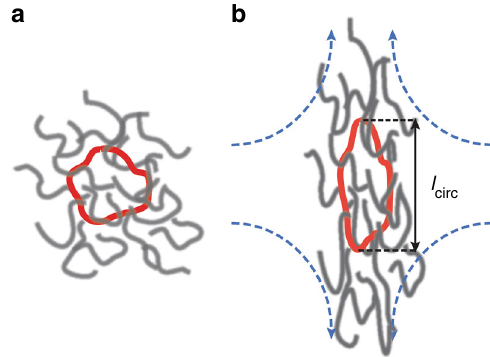
Fig. 1 Schematic of the experimental ring-linear system. Fluorescently labeled tracer ring DNA molecules (45 kbp, shown in red) are uniformly dissolved in a background solution of semidilute linear DNA molecules. Dynamics are studied under a equilibrium (no fl ow) conditions and in b planar extensional fl ow. The transient molecular extension of ring polymers l circ is directly observed using